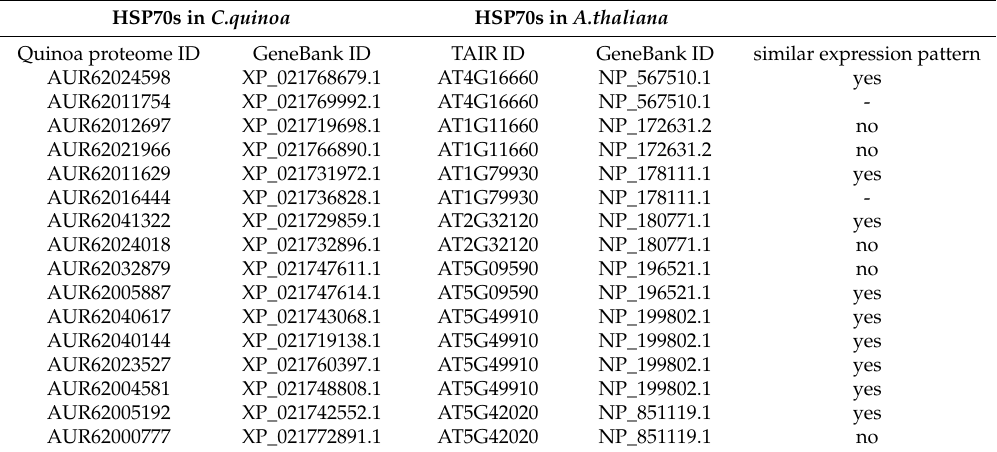
Figure 7. Athsp70 gene expression profiles in response to drought treatment. The preliminary data were retrieved from the published transcriptomics data [21]. Table 2. HSP70s in quinoa and their counterparts in Arabidopsis.